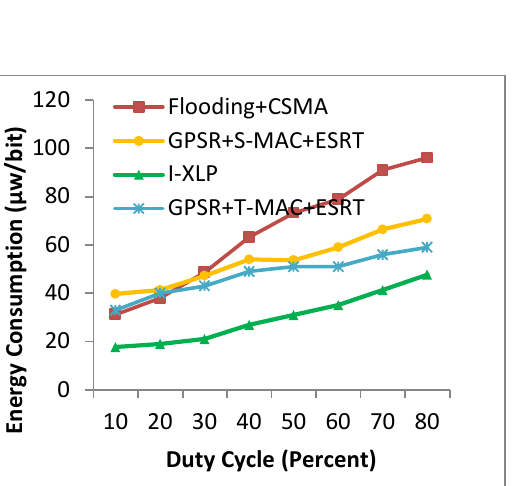
Fig. 11 Average latency vs. duty cycle (for prioritized traffic).